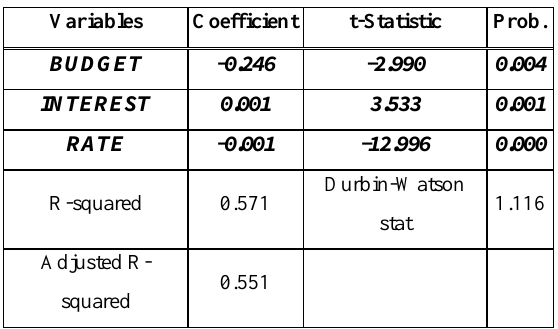
Table 3: Results of Long-Run